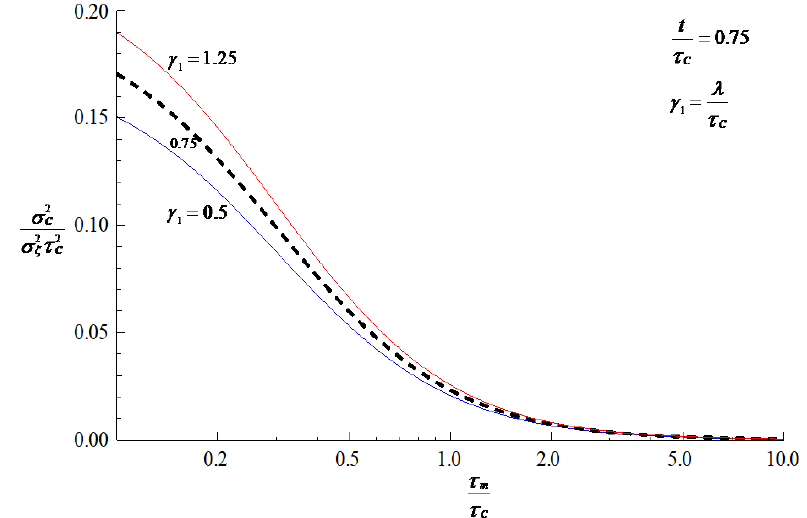
Figure 2. The dependence of dimensionless variance of outflow concentration (Equation (24)) upon the dimensionless catchment mean travel time for various values of the dimensionless correlation scales.